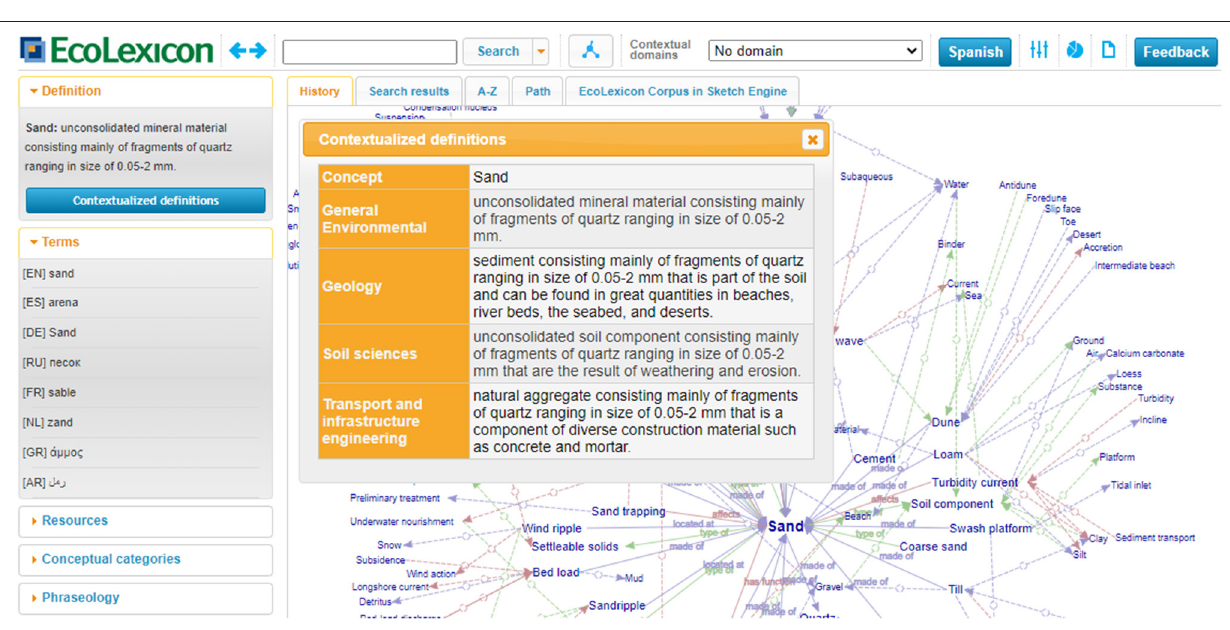
FIGURE 2 | The contextualized definitions of sand in